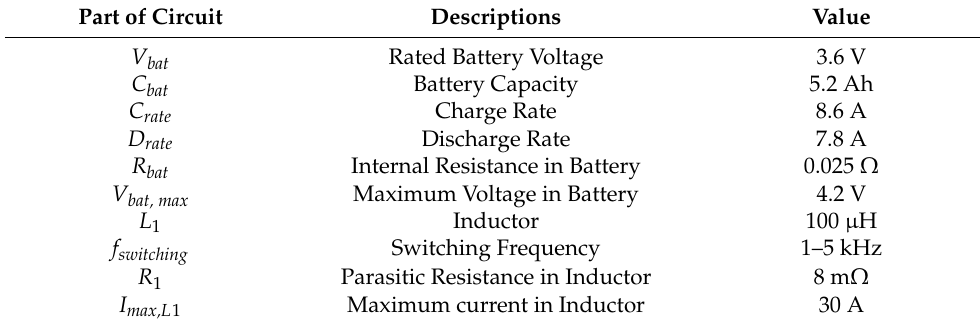
Table 1. System Parameter for Simulation.